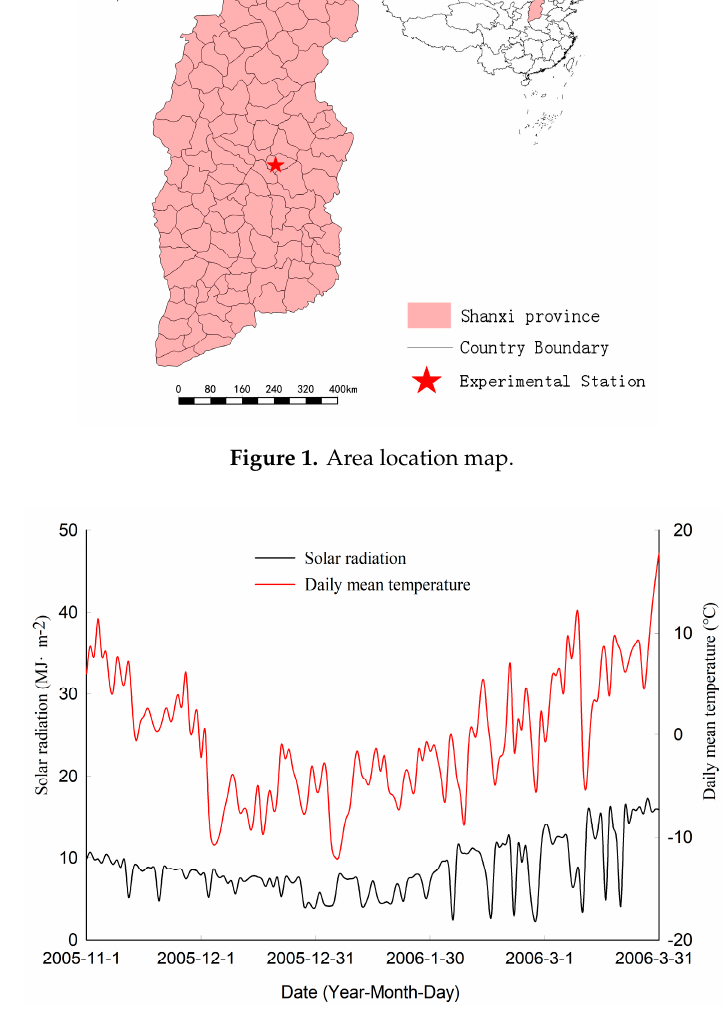
Figure 2. Daily average temperature and solar radiation during the experimental period.